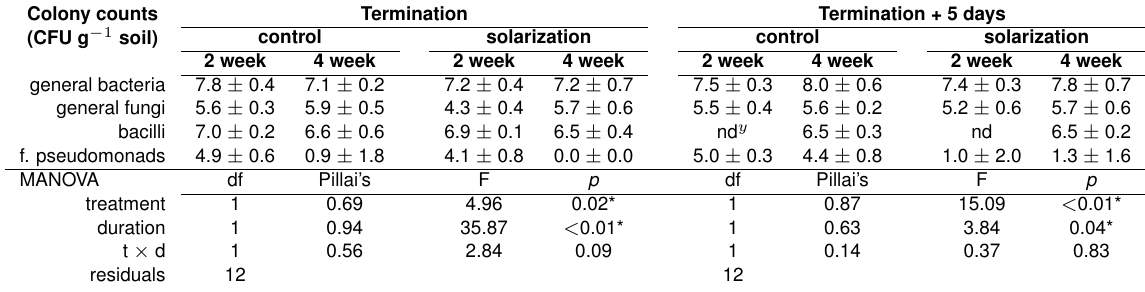
Table 3. Mean ± SD microbial colony counts from GHOUSE experiment and corresponding MANOVA